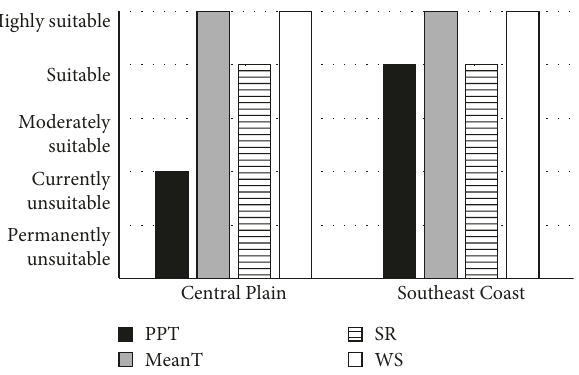
Figure 2: Climatic suitability classification (PPT � annual pre- cipitation; MeanT � annual mean temperature; SR � daily solar radiation; WS � annual wind speed) for oil palm of acid sulfate soils under oil palm planting areas in Central Plain and Southeast Coast,